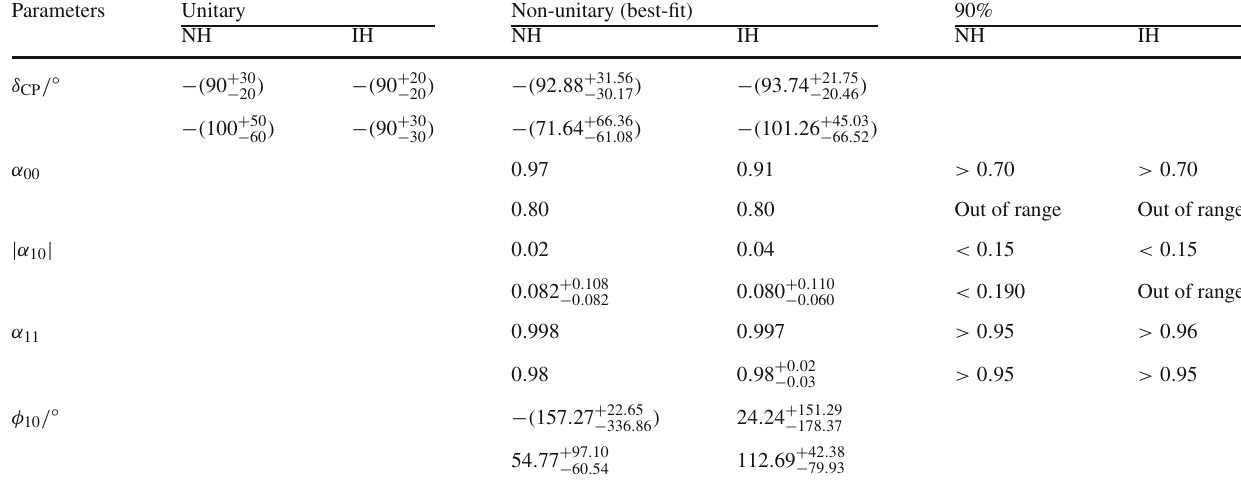
box, the result with 2019 (2020) data has been mentioned at the top (bottom) of the box